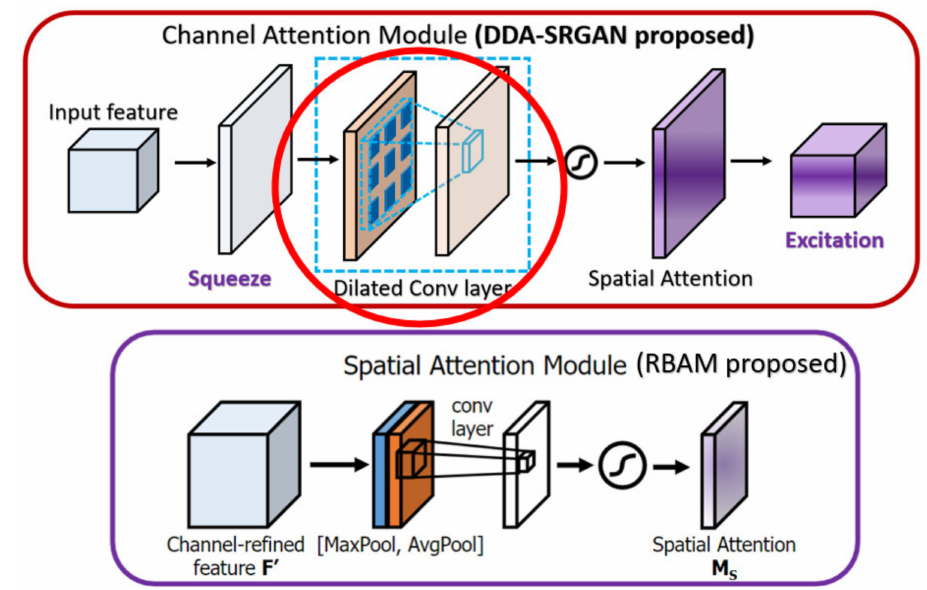
Figure 22. The main difference between the RBAM and DDAB in terms of spatial attention module. The red solid circle indicates the different implementation in our module